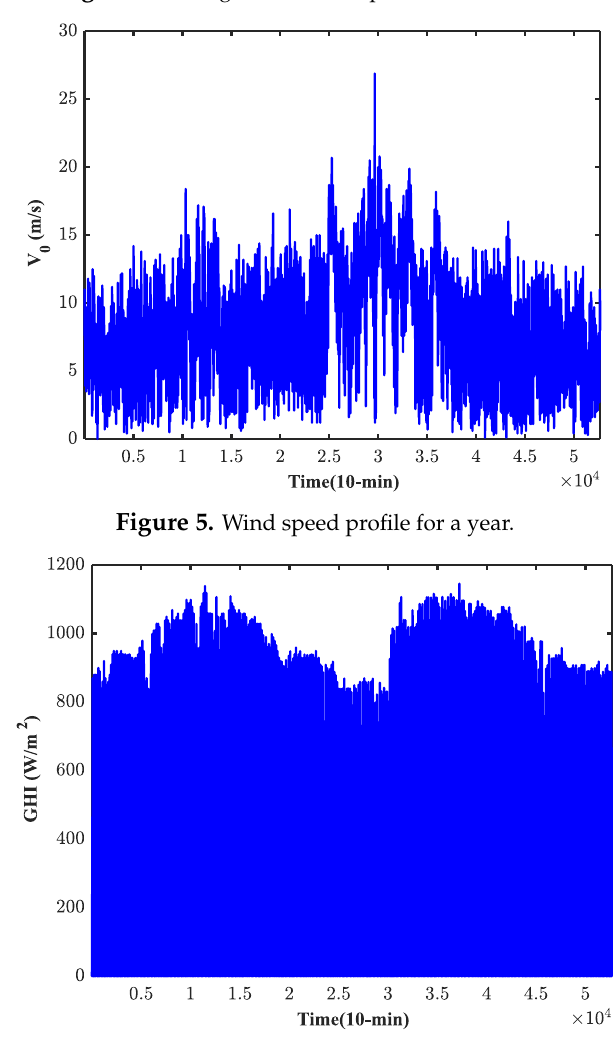
Figure 4. Histogram of wind speed and directions.